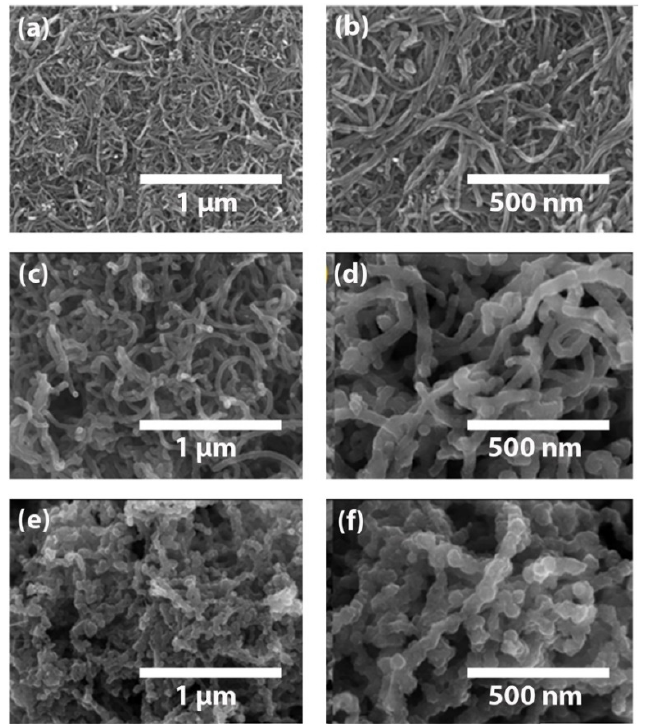
Figure 3. SEM image of ( a ) pure CNT, ( c ) PPy/CNT nanocomposite, ( e ) PPy/CNT- E. coli composite (scale bar: 1 μ m) and high resolution of ( b ) pure CNT, ( d ) PPy/CNT nanocomposite, ( f ) PPy/CNT- E. coli composite (scale bar: 500 nm).